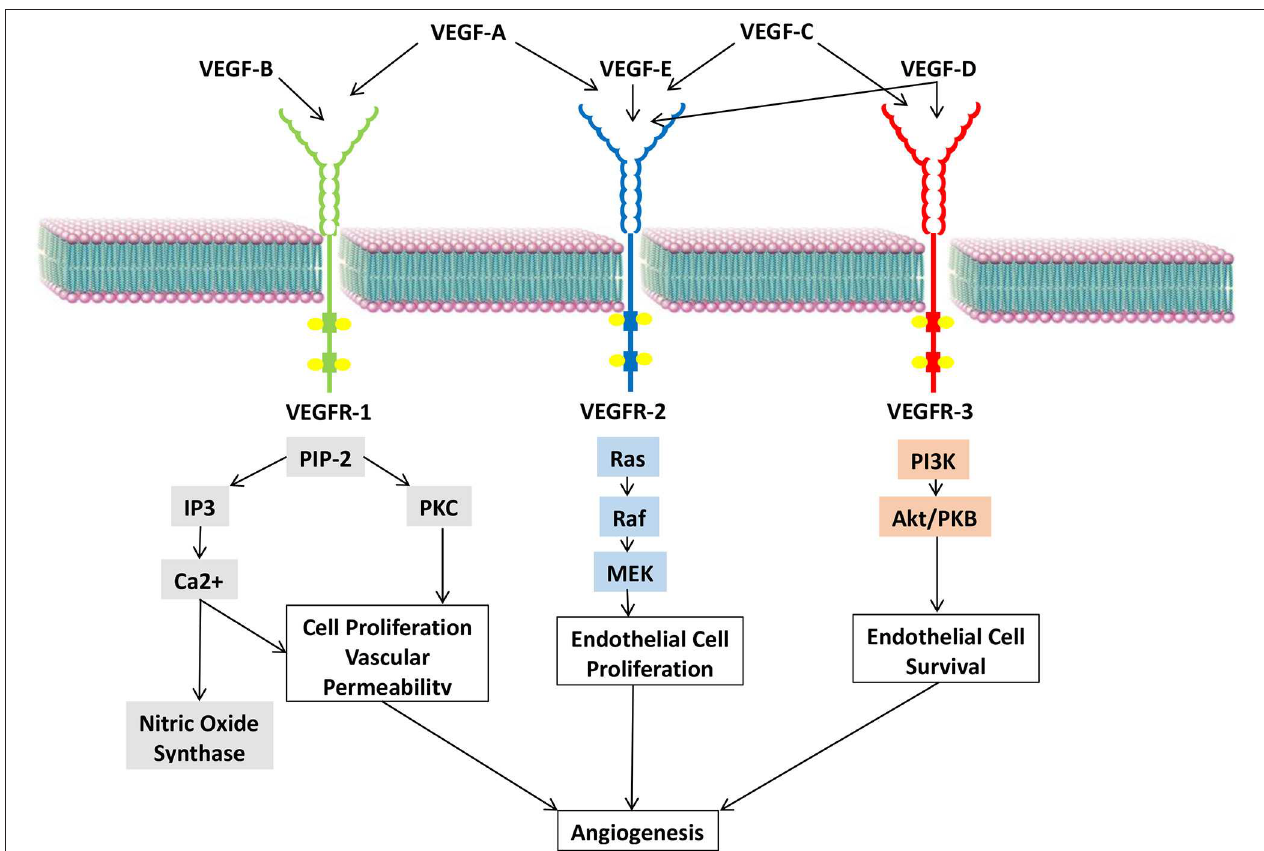
FIGURE 3 | VEGF ligands, their receptors, and respective signaling